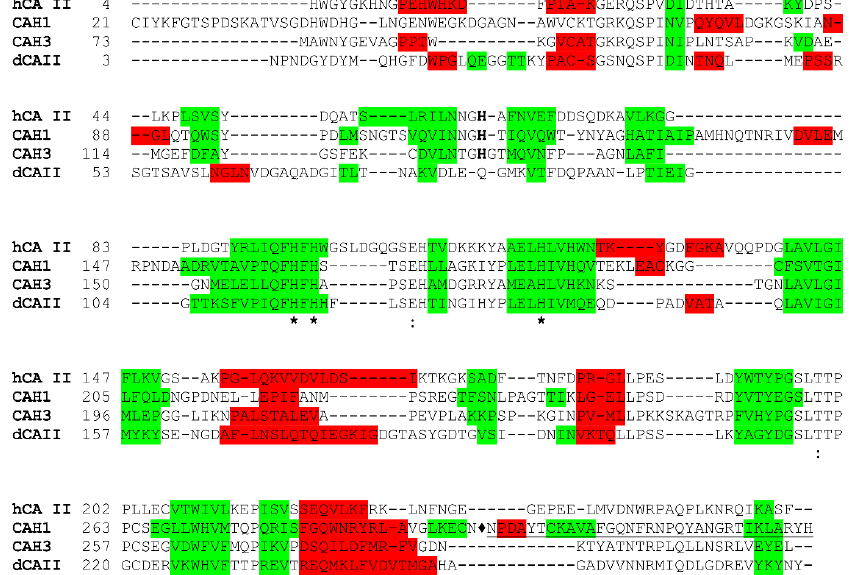
Figure 3. Structure-based sequence alignment of hCA II with the green algal α -CAs with known structure: CAH1 and CAH3 from C. reinhardtii and dCAII from D. salina . Histidine proton shuttles are represented in bold, while zinc coordinating histidines and gatekeeper residues Thr199 and Glu106 (hCA II numbering) are indicated with (*) and (:), respectively. For CAH1, residues of the small subunit (345 – 377) are underlined and ♦ indicates the break between small and big subunit (residues 21 – 297). The α -helix regions are colored in red and β -strand regions in green. Secondary structural elements are calculated with the DSSP program [84,85].